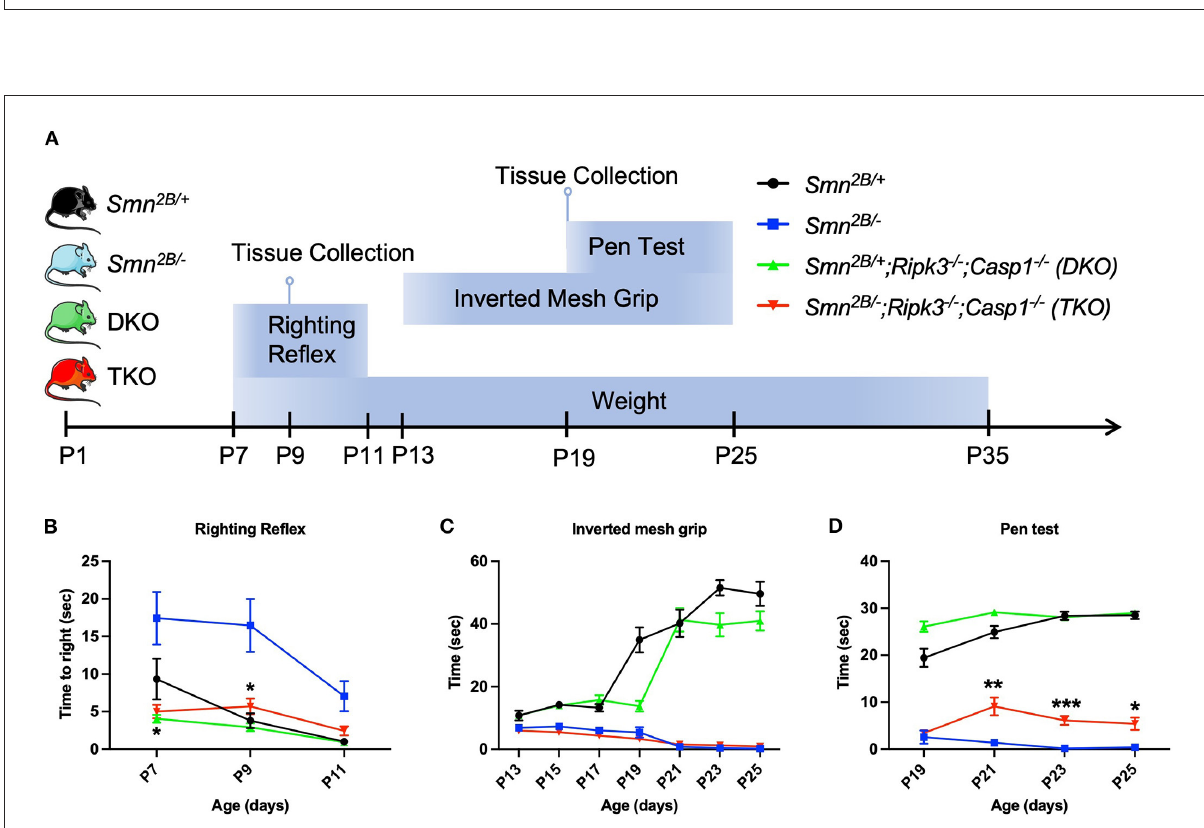
FIGURE3 Impact of genetic ablation of necroptotic cell death pathways on motor function in Smn 2 B / − mice. (A) Schematic representation of experimental design and evaluation of motor function. Motor function and weight were evaluated every second day in each group with (B) righting reflex from P7 to P11, (C) inverted mesh grip test from P13 to P25, and (D) pen test from P19 to P25. Minor motor improvement could be identified in the TKO mice on the righting reflex and the pen test while no improvement was seen on inverted mesh grip test. η = 11 − 19 per genotype. Data represents means ± SEM. An ordinary two-way ANOVA with Sidak’s post-hoc test for multiple comparison. P < 0.05 for * , P < 0.001 for ** , and P < 0.0002 for ***